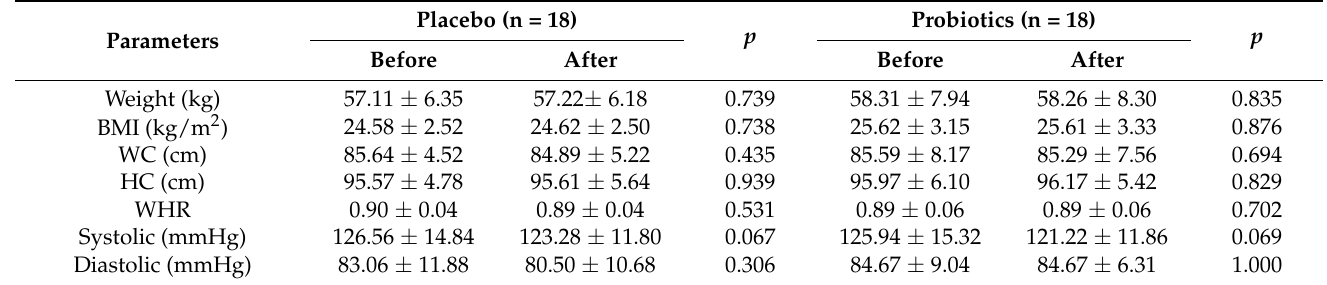
Table 3. Anthropometric and blood pressure before and after intervention in both